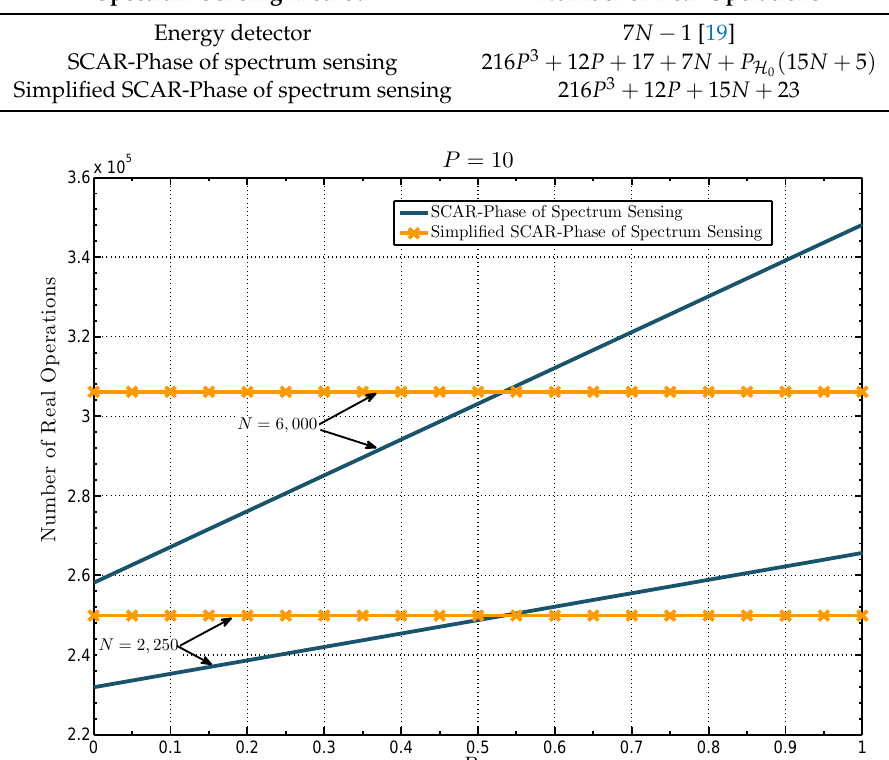
Figure 6. Computational complexity in terms of number of real operations against P H number of samples N